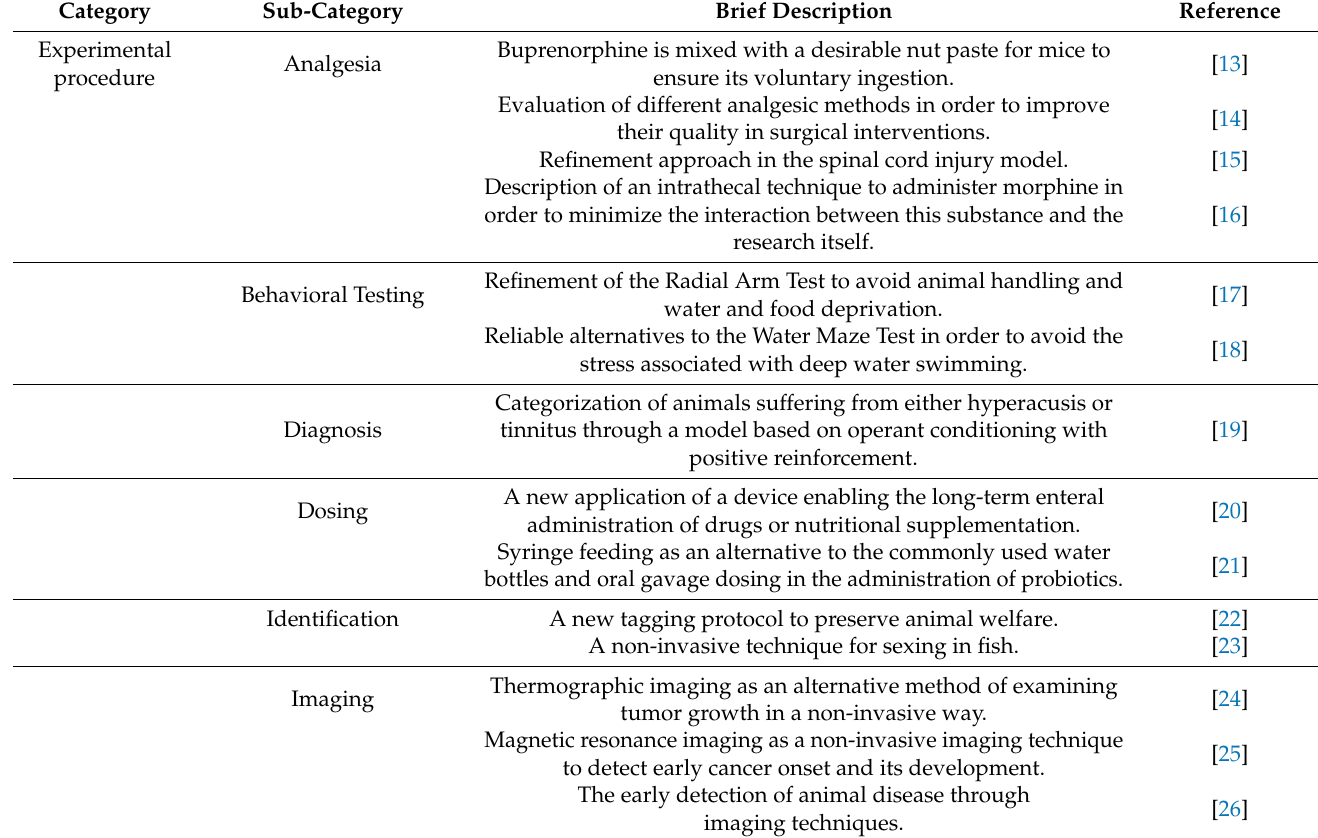
Table 1. Classification of the studies by category and sub-category.